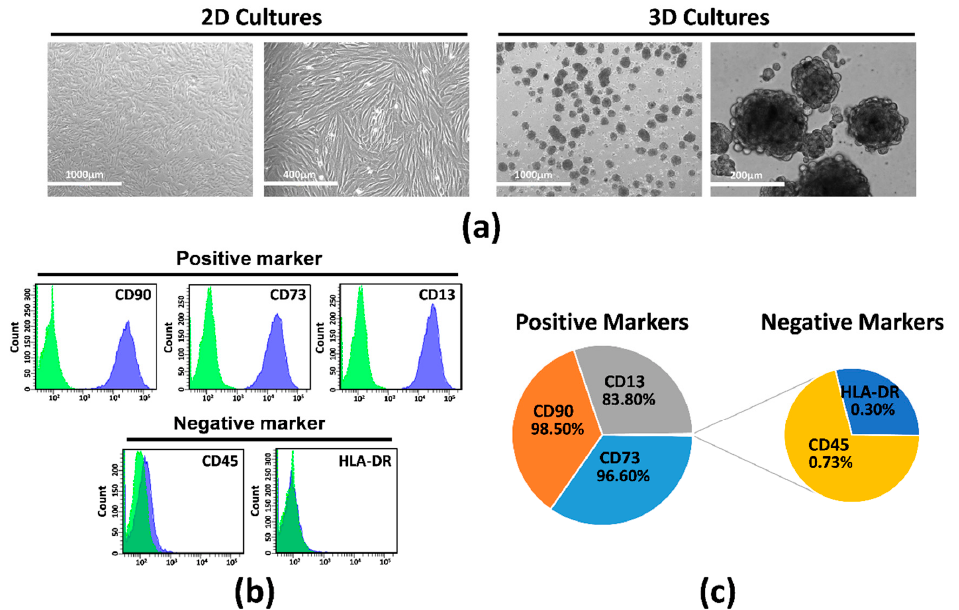
Figure 1. Human amnion mesenchymal stem cells (hAMSCs) grown as both monolayer and spheroids. ( a ) Representative DIC images of hAMSCs grown in monolayer (2D cultures) or as spheroids (3D cultures). ( b ) Representative images of flow cytometry analysis for quantification of both positive and negative surface markers in hAMSCs at Passage 0. Green represents isotype control, and blue represents stained cells. ( c ) Graphic depicts the percentage of each marker. DIC, differential interference contrast.